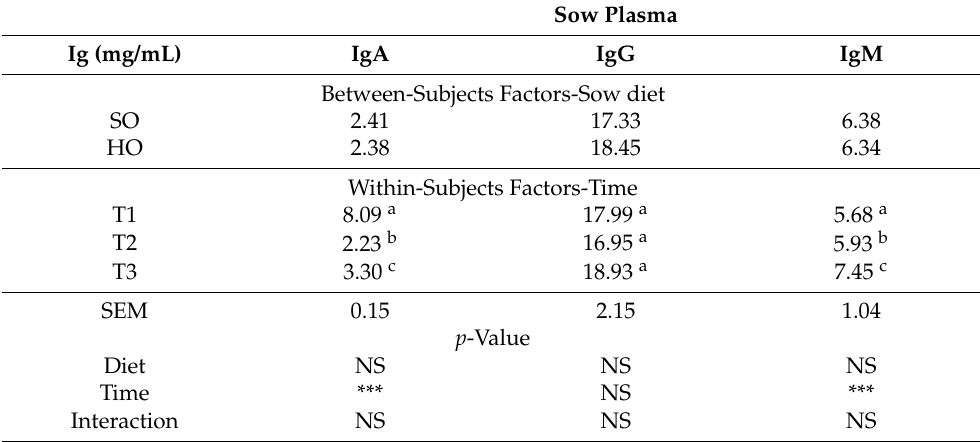
Table 6. Ig composition of plasma from sows fed a classical diet based on soybean oil (SO) or a rich n-3 FA and lower n-6:n-3 ratio diet based on hemp seed oil (HO) at different time points after farrowing (12 h, 10 days, and 21